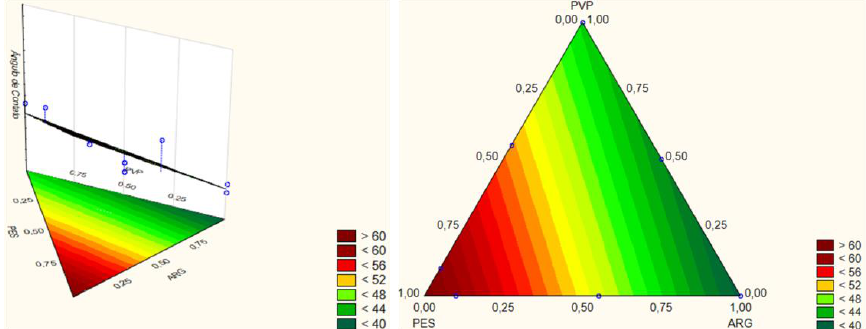
Figure 8. Response surface graph and contour graph according to the linear model for the contact angle.